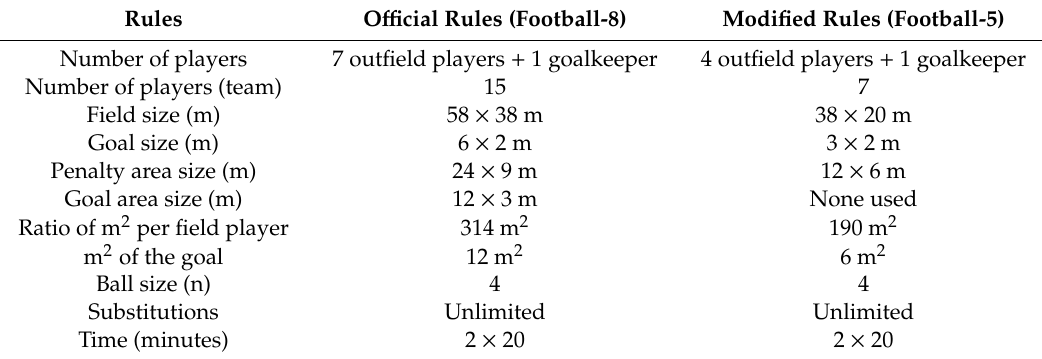
Table 1. Description of the rules implemented in the tournaments (football-8 and